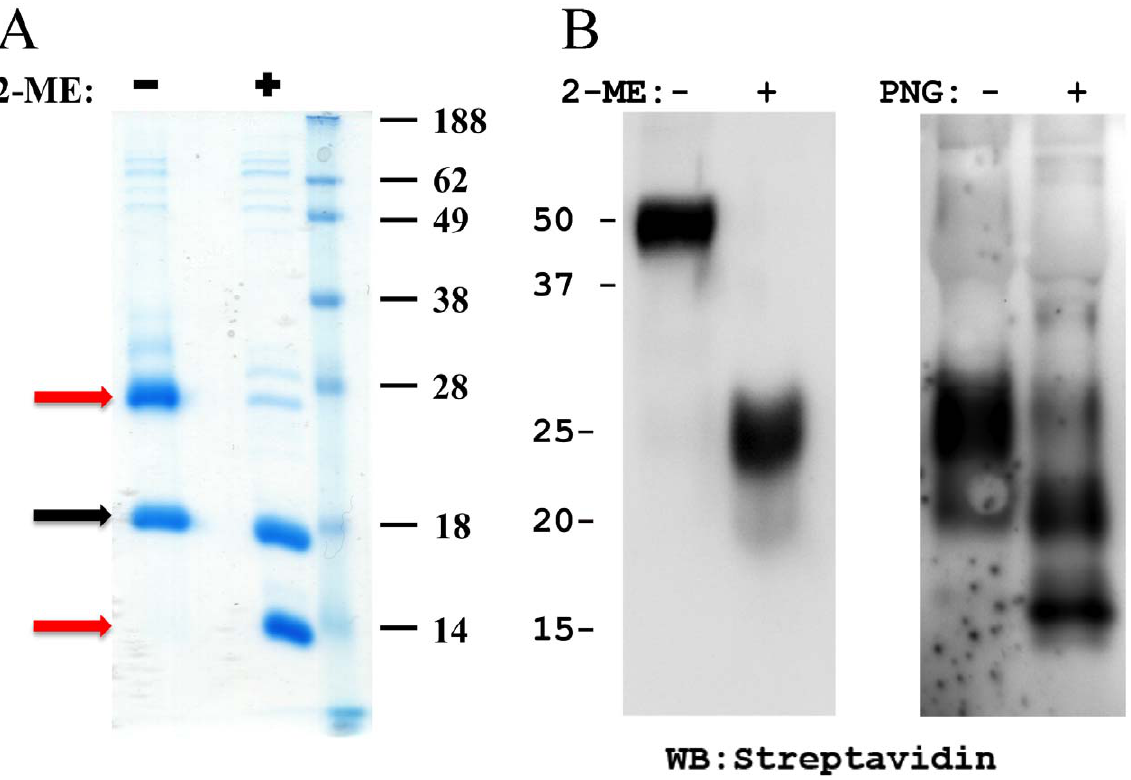
Figure 4. YLDV-IL18BP forms a SS linked dimer in solution. SDS-PAGE analysis of purified YLDV-IL18BP proteins in the presence ( + ) or absence ( 2 ) of 2-mercaptoethanol (2-ME). A). Purified YLDV-IL18BP:IL18 protein complex that was expressed in E. coli . IL18 and YLDV-IL18BP are indicated by black and red arrows, respectively. B). Purified YLDV-IL18BP that was expressed and secreted from mammalian cells. The YLDV-IL18BP was engineered with a C-terminal site-specific biotinylation site, which allows its detection in Western blot with streptavidin. Two N-glycosylation sites were predicted for YLDV-IL18BP. Panel B also shows the SDS-PAGE of YLDV-IL18BP that was untreated ( 2 ) or treated ( + ) with endoglycosidase PNGase